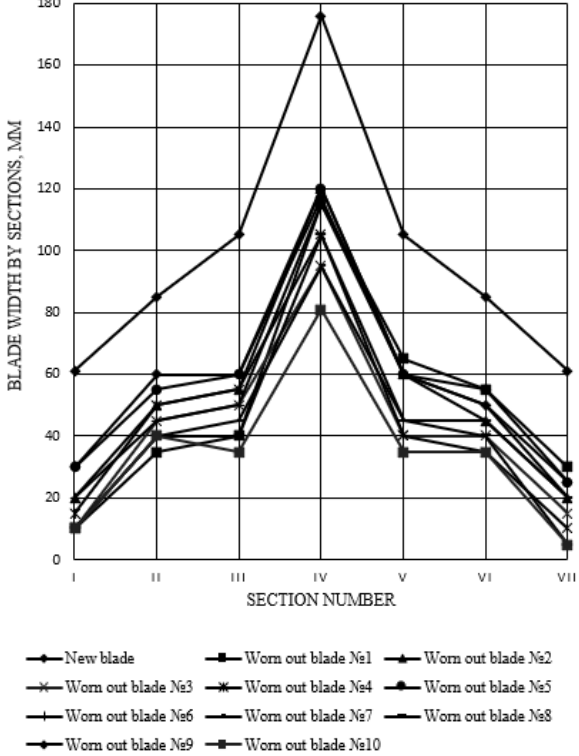
Fig.7. Changing cultivator blades sizes of 9.3 "TigerMate II made in Canada by sectional zones (according to Fig.